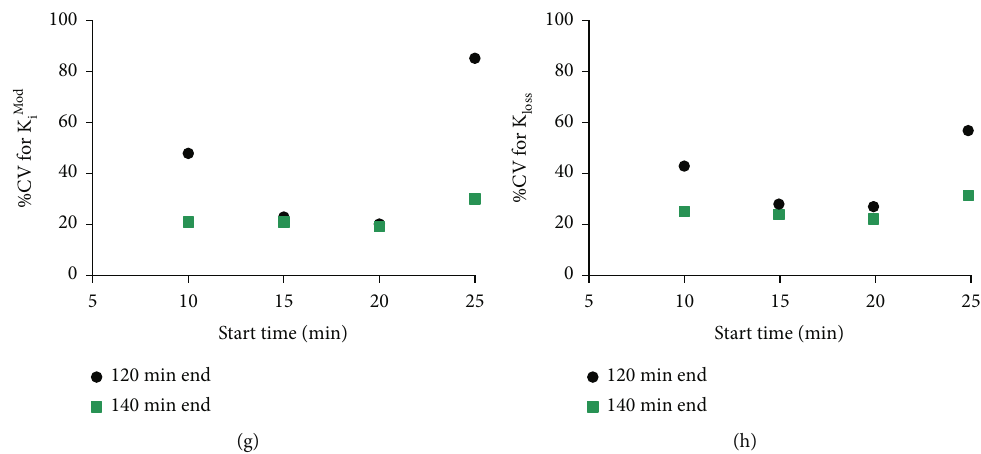
k Figure 2: E ff ect of varying T ∗ and T end on K values and intersample variability following i.p. radiotracer administration. (a, b) i Mod and loss Values calculated from TACs following i.p. radiotracer administration ( N = 13 ) by the extended Patlak analysis for K i Mod (a) and k with variable T ∗ ( x -axis) and T end (60 min: red triangles; 90 min: blue open squares; and 120min: black circles). Values are mean ± S : D : (c, d) %CV for K i Mod (c) and k (d) with variable T ∗ and T end . (e – h) As (a – d) but showing the e ff ect of varying T ∗ ( x -axis) on K i Mod loss (e) and k (f) outcome values and S.D. as well as %CV for K i Mod (g) and k (h) using a T end of 120min (black circles) or 140min loss loss (green squares).